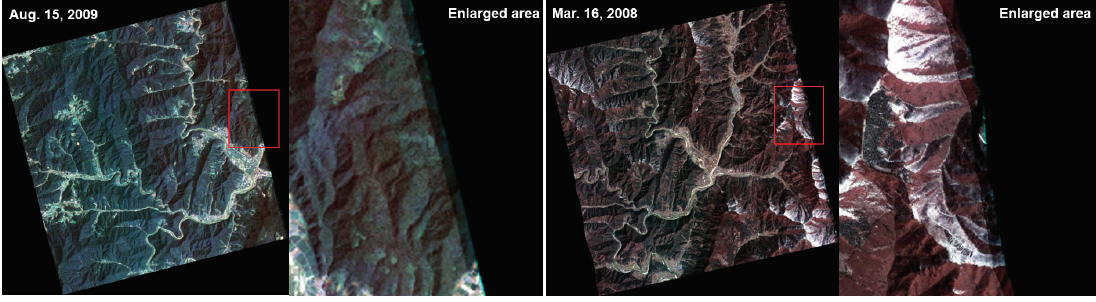
Figure 5. The false color values along the right side of the Kompsat-2